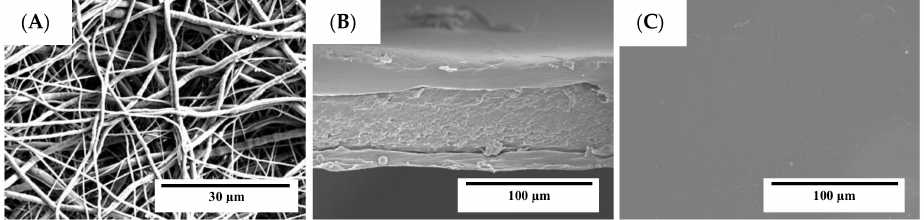
and ( C ) active multilayer surface.